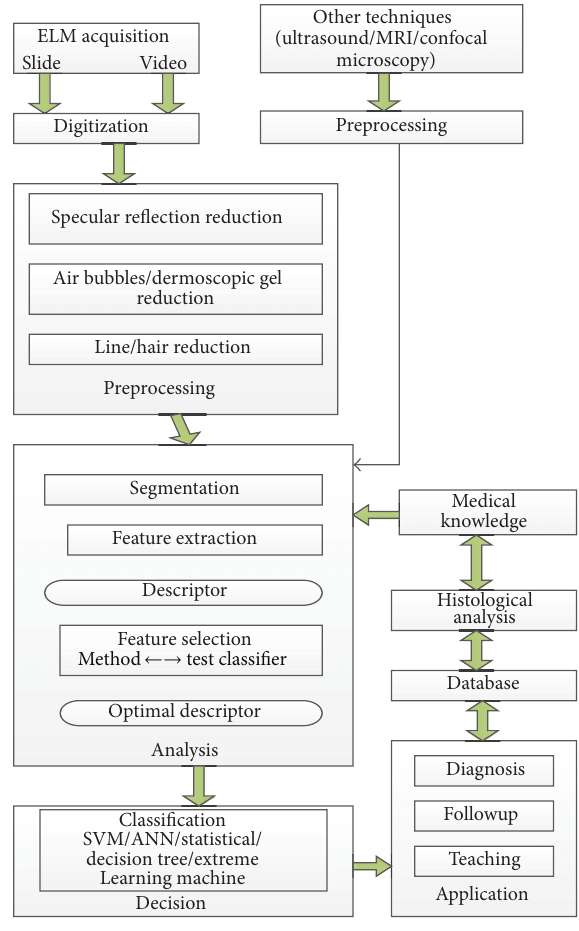
Figure 1: Computer aided diagnostic support system for skin cancer